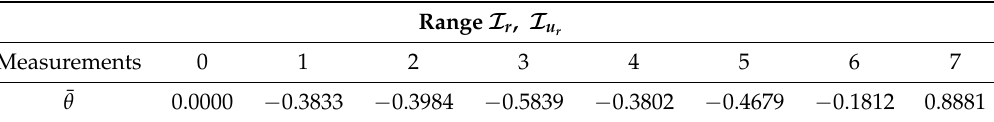
Table 4. Calculated Lagrange multipliers.